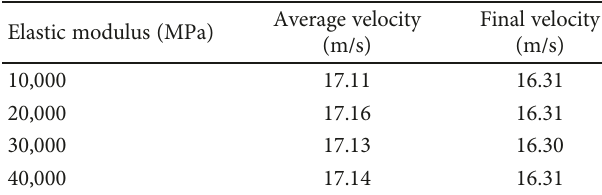
Figure 22: Velocity of the missile when leaving the canister at di ff erent elastic modulus. Table 3: The e ff ect of elastic modulus on